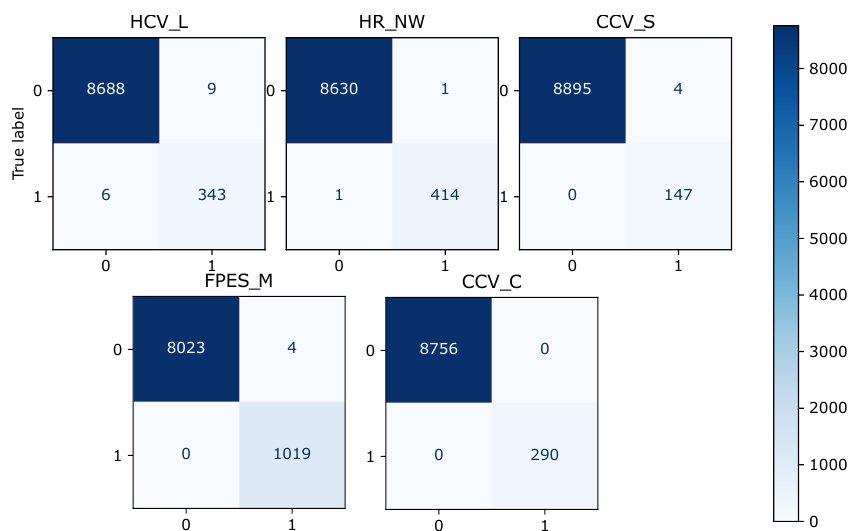
Figure 5. Diagram of the confusion matrix of different fault classes for the XGBoost model and for five fault